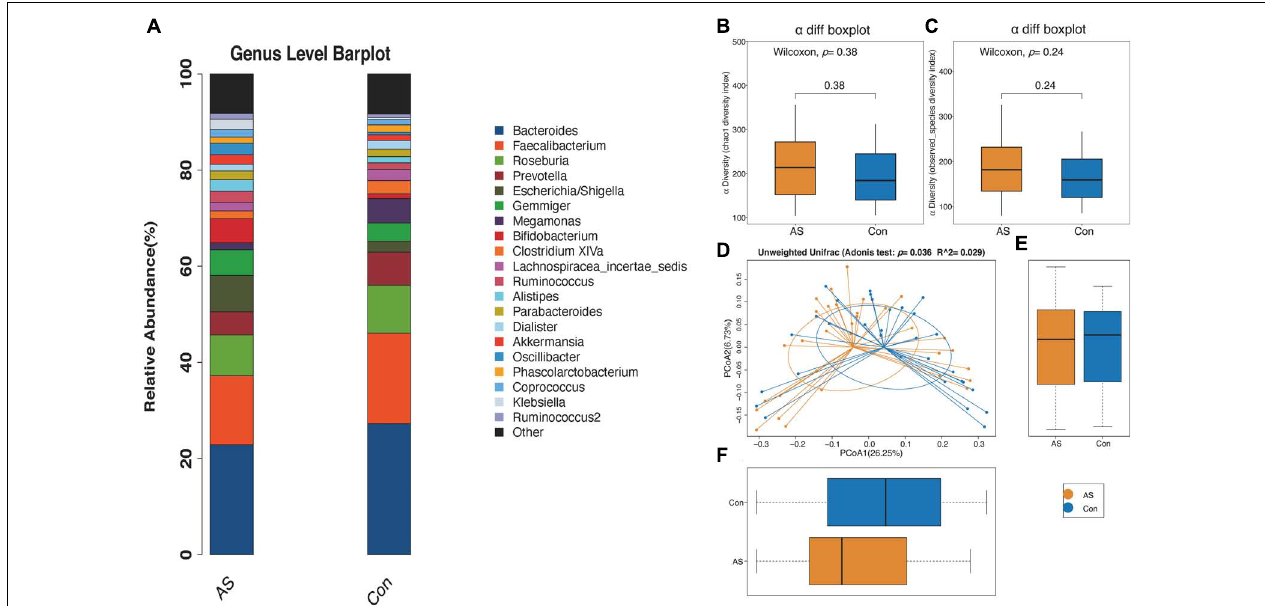
FIGURE 2 | Microbial diversity of CAS patients and healthy controls. (A) Relative abundance of gut microbiota for two groups from genus level. (B,C) α -Diversity (chao1 and observed_species) for two groups showed no significant difference. (D–F) β -Diversity is significantly increased for CAS patients.